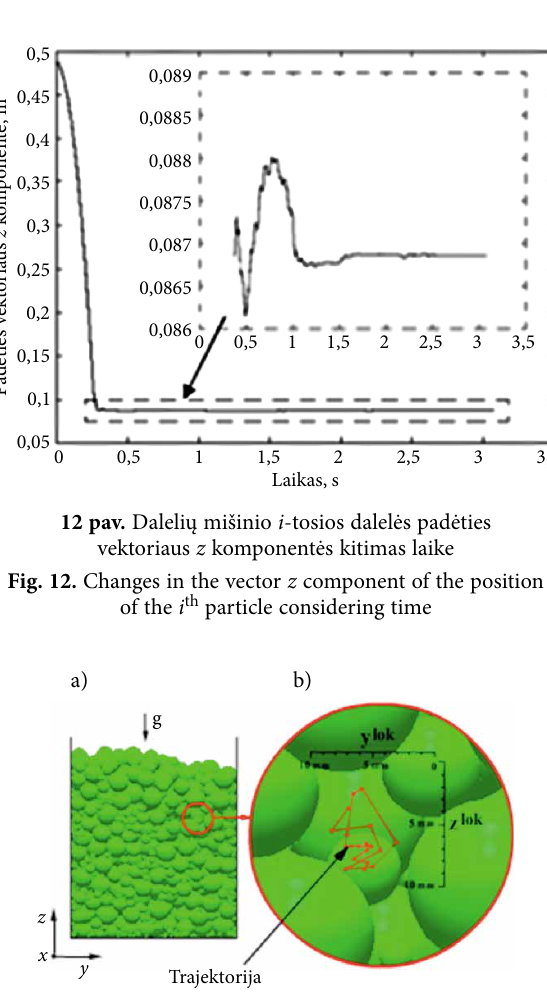
Fig. 13. Internal structure of the particle mixture in the quasistatic equilibrium state: a – inactive zone in the mixture; b – trajectory of changes in the position of the mass centre of the i th particle centre is displayed in the local coordinate